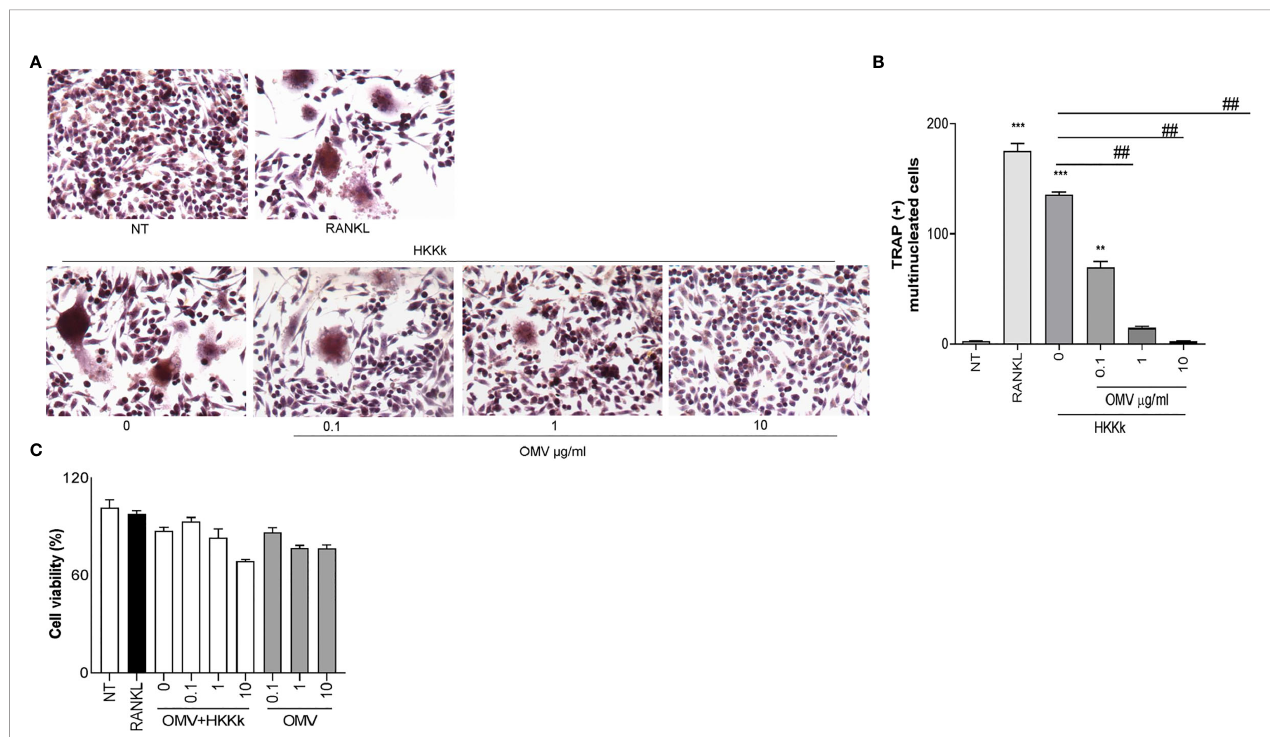
FIGURE 9 | Outer membrane vesicles (OMV) inhibits osteoclast differentiation induced by HKKk. RAW 264.7 cells were stimulated HKKk (1 × 10 5 bacteria/ml) pretreated with OMV (0, 0.1, 1, and 10 µg/ml) in conjunction with macrophage colony-stimulating factor. After 7 days, osteoclastogenesis was determined by the generation of multinucleated TRAP-positive cells (more than three nuclei). Representative digital images were taken by light microscopy (A) , and TRAP-positive multinucleated cells were identi fi ed and counted (B) . Cell viability was measured by MTT colorimetric assay; results were expressed as percent of control (NT cells) (C) . RANKL was used as a positive control. NT, non-treated. The graphics are showing values obtained from three independent experiments. Data are given as mean ± SD. ** P < 0.01; *** P < 0.001 versus NT. ## P <